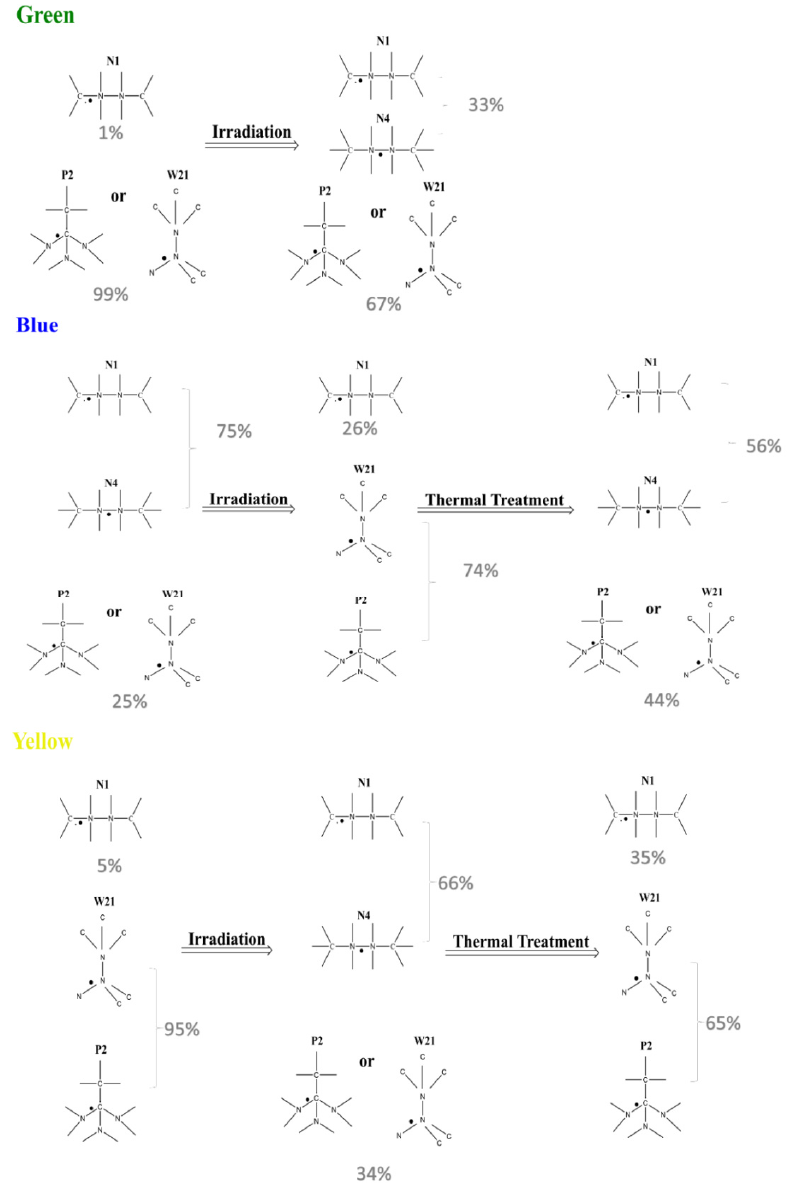
Figure 7. Schematic paramagnetic centers before and after treatments for green, blue, and yellow diamonds. In green diamonds, there is an increase in the N1 species concentration and appearance of the N4 (formed by the irradiation treatment) species; in blue diamonds, there is an increase in the P2/W21 species concentration (formed by the irradiation treatment) and appearance of the N4 spe- cies concentration (formed by the annealing treatment); in yellow diamonds, there is an increase in the N1 species concentration and appearance of N4 (formed by the irradiation treatment) and also an increase in the concentration of the P2/W21 species (formed by the irradiation treatment) and disappearance of the N4 species (formed by the annealing